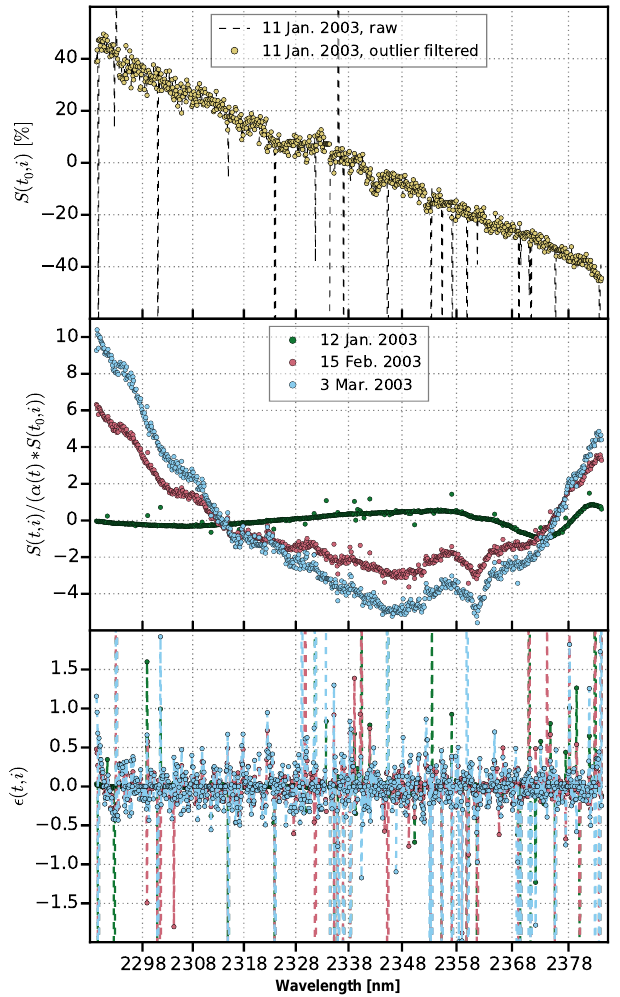
Figure 4. Upper panel: first SMR spectrum of 11 January 2003 ex- pressed as the deviation from its mean signal This spectrum is used as reference in the following panels. Bad pixels were filtered and interpolated. Middle panel: SMR spectra for three example orbits divided by the reference and smoothed with a running median filter of 10 pixels half width. Lower panel: residuals of the smoothing.